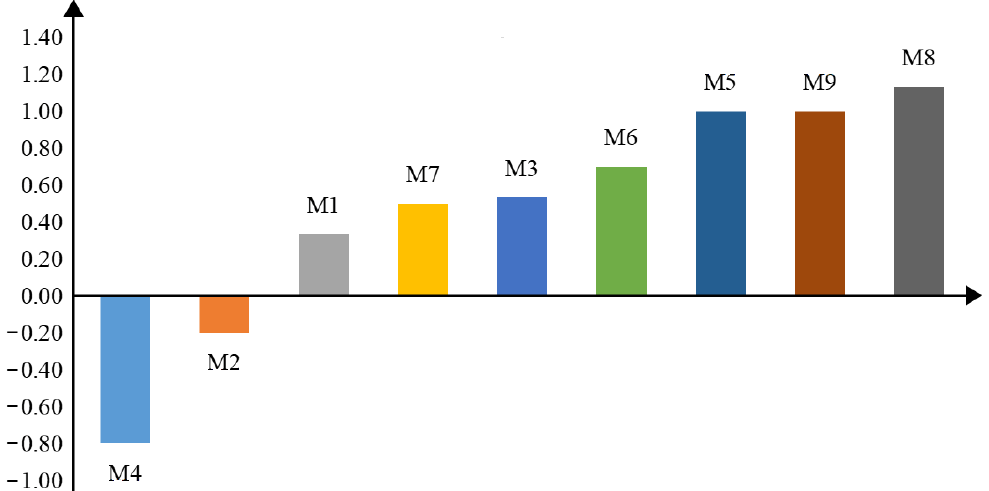
Figure 6. Subjective tactile comfort evaluation (M1: Joinery board, M2: PVC board, M3: Fireproof board, M4: Solid wood board, M5: Painted solid wood board, M6: Melamine board, M7: Painted board, M8: Blister board, M9: Quartz board).